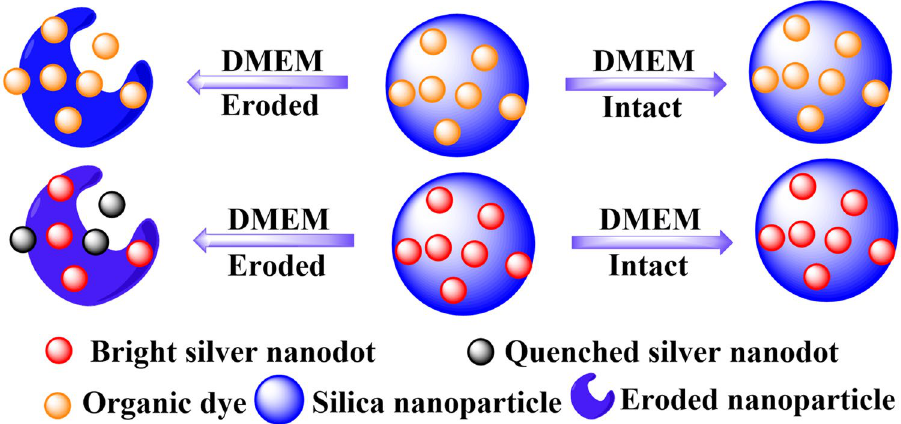
Figure 1. Schematic showing that silver nanodots-encapsulated in silica reveals the erosion of